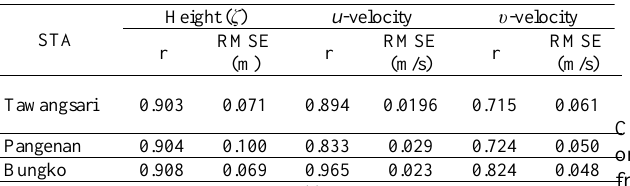
Table 1 Correlation coefficient (r) and RMS Error between MIKE simulation and TPXO9 for water level and velocity components from TMD